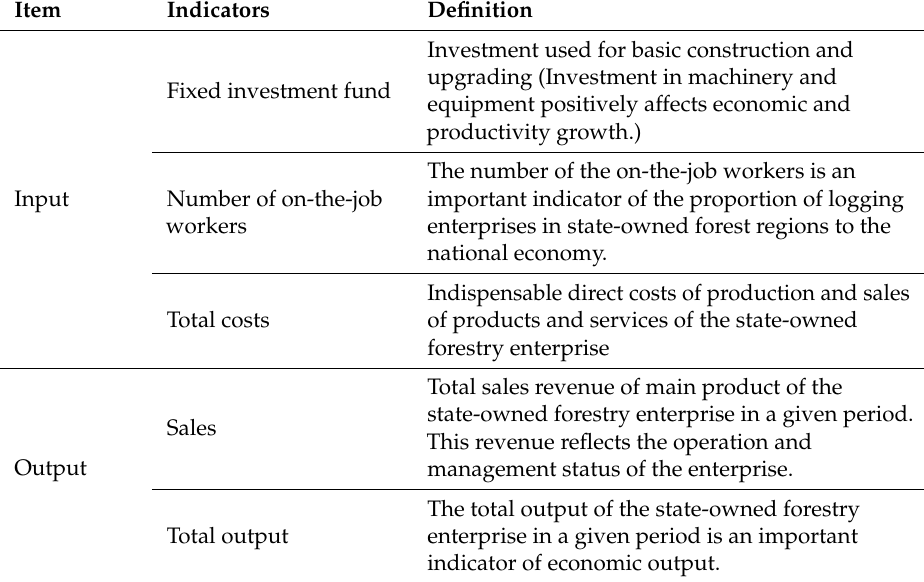
Table 1. Malmquist data envelopment analysis (DEA)–based system of evaluation indices of production